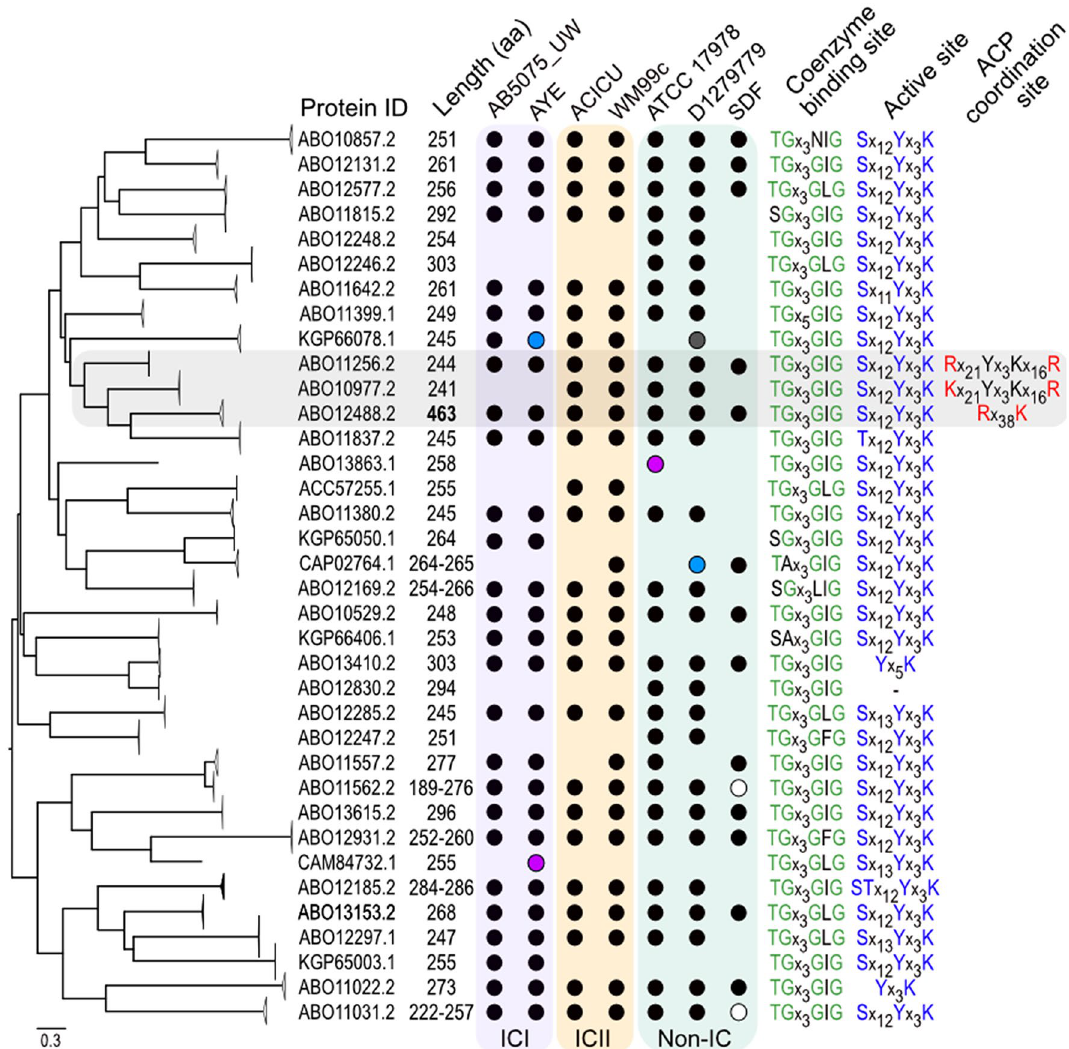
Figure 1. Bioinformatic analysis of the A. baumannii short-chain dehydrogenase/reductases. A. baumannii short-chain dehydrogenase/reductases are separated into multiple distinct phylogenetic clades. A midpoint rooted maximum likelihood phylogenetic tree was generated from 175 aligned putatively annotated SDR protein sequences identified from seven distinct A. baumannii strains; AB5075_UW, AYE, ACICU, WM99c, ATCC 17978, D1279779 and SDF. Clades were collapsed for clarity in FigTree v1.4.4 and subsequently labelled using a representative protein accession ID. The consensus protein length identified for each clade are displayed in amino acids (aa). Bold-face type represents a putative high molecular weight 3-oxoacyl ACP reductase. Black filled circles represent the presence of a protein sequence within a given clade from the investigated A. baumannii genomes. Blue and white filled circles indicate protein sequences that are divided across two open reading frames and have C-terminal truncations, respectively. Purple filled circles indicate sequences present on endogenous plasmids. Grey filled circle indicates the presence of a sequence but encoded at a different genetic location to other identified clade members. Transparent purple, orange and green boxes indicate strains classified as international clone I (ICI), international clone II (ICII) and non-international clone (Non-IC) lineages, respectively. Consensus sequences of coenzyme binding and catalytic active site fingerprint motifs from each clade are shown, with conserved residues coloured in green and blue font, respectively. Consensus sequences of conserved charged residues responsible for coordination of acyl-acyl carrier protein (ACP) binding are shown in red font. See Supplementary Figure 1 for comparative alignment of short-chain dehydrogenase/ reductases. ACP-coordinating residues for the putative high molecular weight FabG of A. baumannii (clade ABO12488.2) were identified using a comparative alignment against FabG4 of Mycobacterium tuberculosis 19 . Transparent grey box indicates clades with potential 3-oxoacyl ACP reductase activity. A. baumannii protein identifiers are as follows; ATCC 17978, (ABO); AB5075_UW, (KGP); ACICU, (ACC); SDF, (CAP) and AYE,